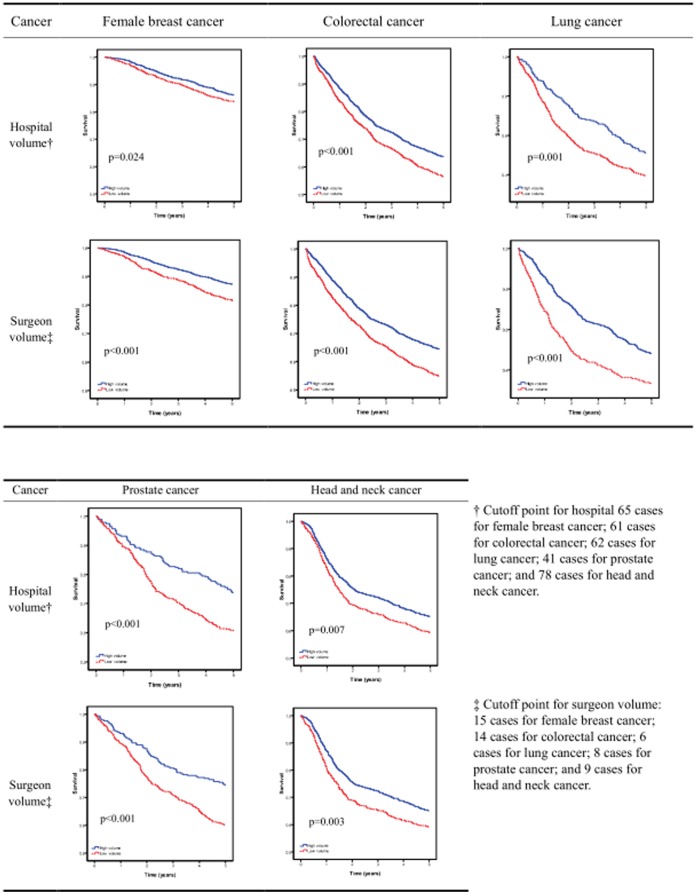
Procedure for definition of hospital volume and surgeon volume.(1) Hospitals were further categorized by their total patient volume by using unique hospital identifiers in this database. The cancer patients fell in to three approximately equal groups based on hospital volume. (2) Surgeons were further categorized by their total patient volume by using unique hospital identifiers in this database. The cancer patients fell in to three approximately equal groups based on surgeon volume. (3) These cancer patients were then linked to the death data extracted from the catastrophic illness and cancer dataset covering the years 2002–206. (4) 5-year survival of the cancer patients were analyzed according to hospital volume or surgeon volume stratified by tumor sites. (5) In Lung cancer and prostate cancer, survival curves of the medium and low hospital/surgeon group were similar. So the medium and low groups were merged as the “low volume”. (6) In breast cancer, colorectal cancer, and head and neck cancer, survival curves of the high and medium hospital/surgeon group were similar. So the high and medium groups were merged as the “high volume”. (7) The cutoff point of each cancer in hospital level or surgeon level was derived from the above procedures (5) and (6).